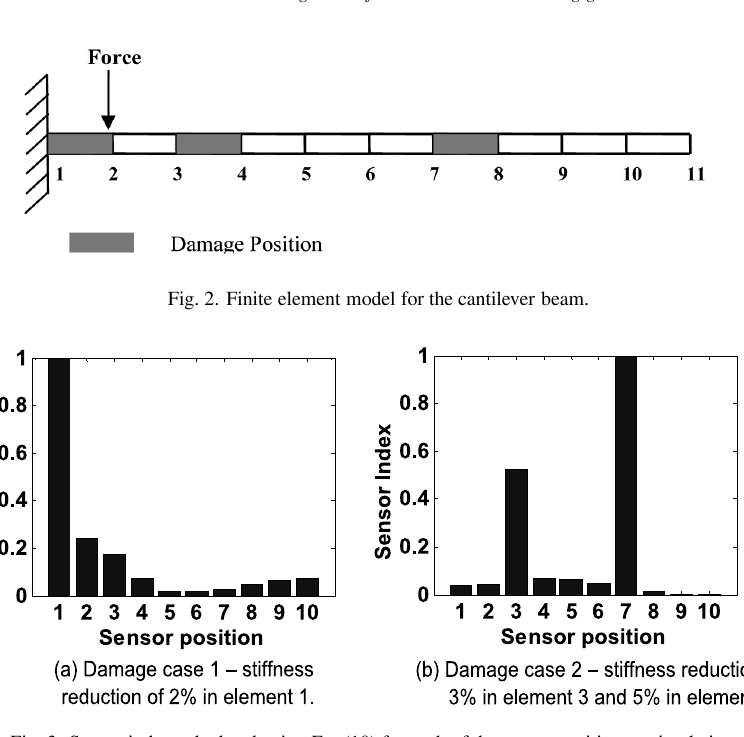
Fig. 3. Sensor index calculated using Eq. (10) for each of the sensor positions –